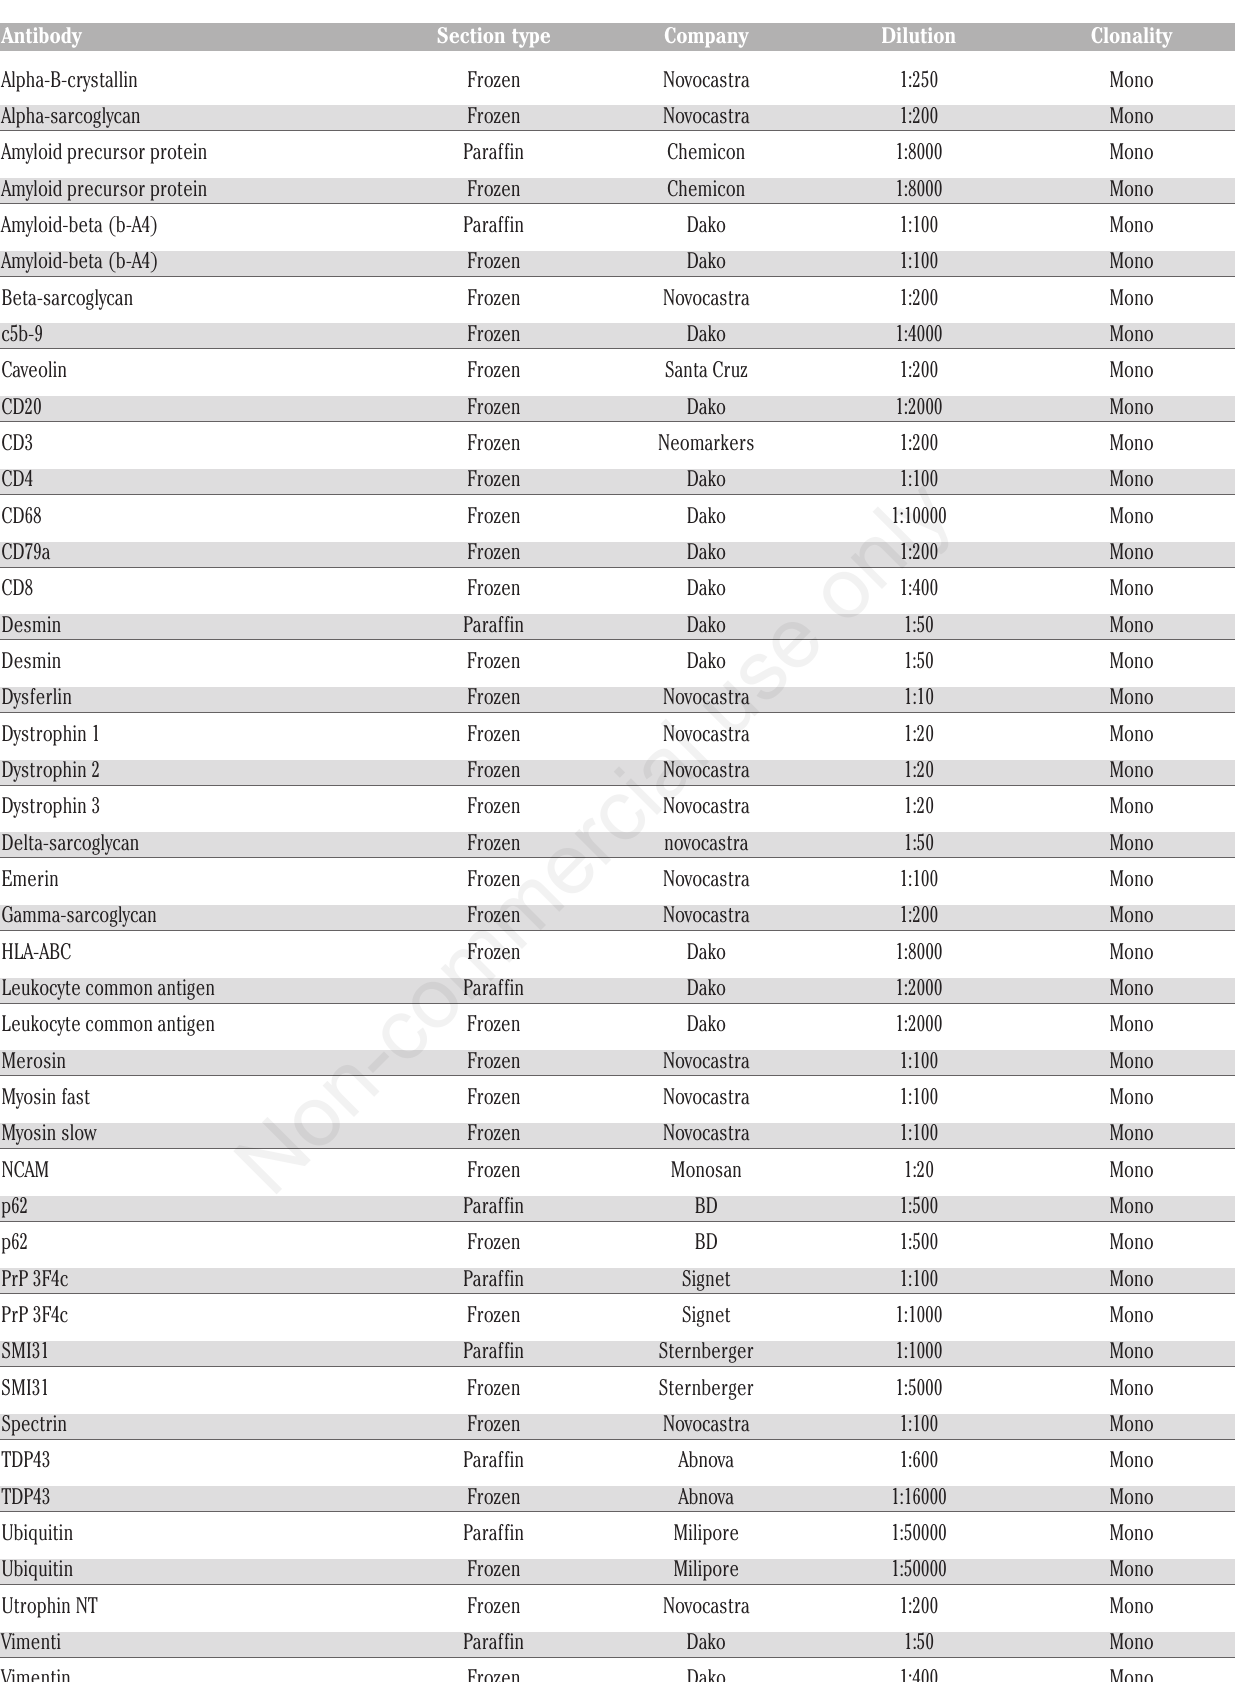
Table 1. List of antibodies applied during the histological work-up of the muscle biopsy. Positivity was found for antibodies against CD3, CD8, CD68, NCAM, p62, and SMI31.